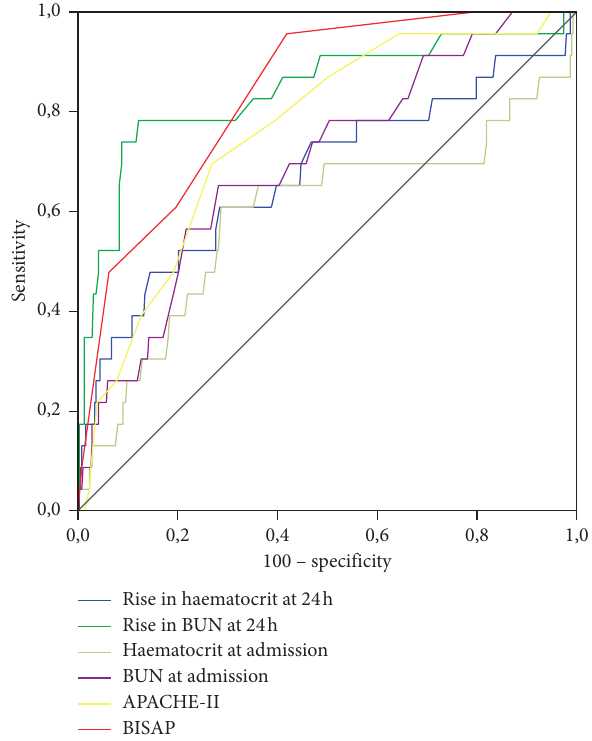
Figure 1: Comparison of ROC curves for